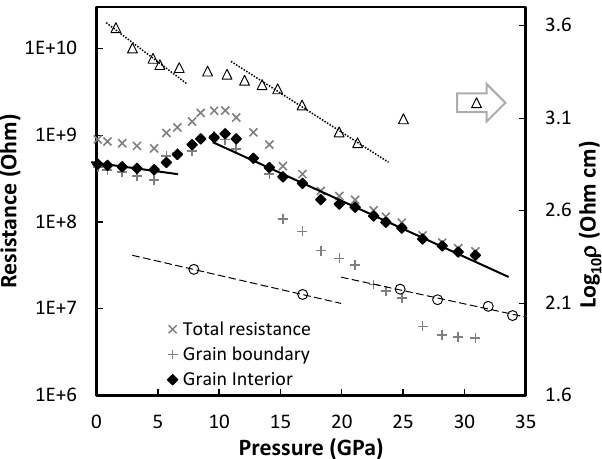
Figure 5. Measured grain-interior resistance (R gi : solid diamonds), grain-boundary resistance (R gb : pluses), and total resistance (R = R g + R gb : crosses) of the goethite sample at di ff erent pressures using electrical impedance spectroscopy. Triangles and open circles are the resistivity and resistance from Liu et al. [12] and Xu et al. [10],